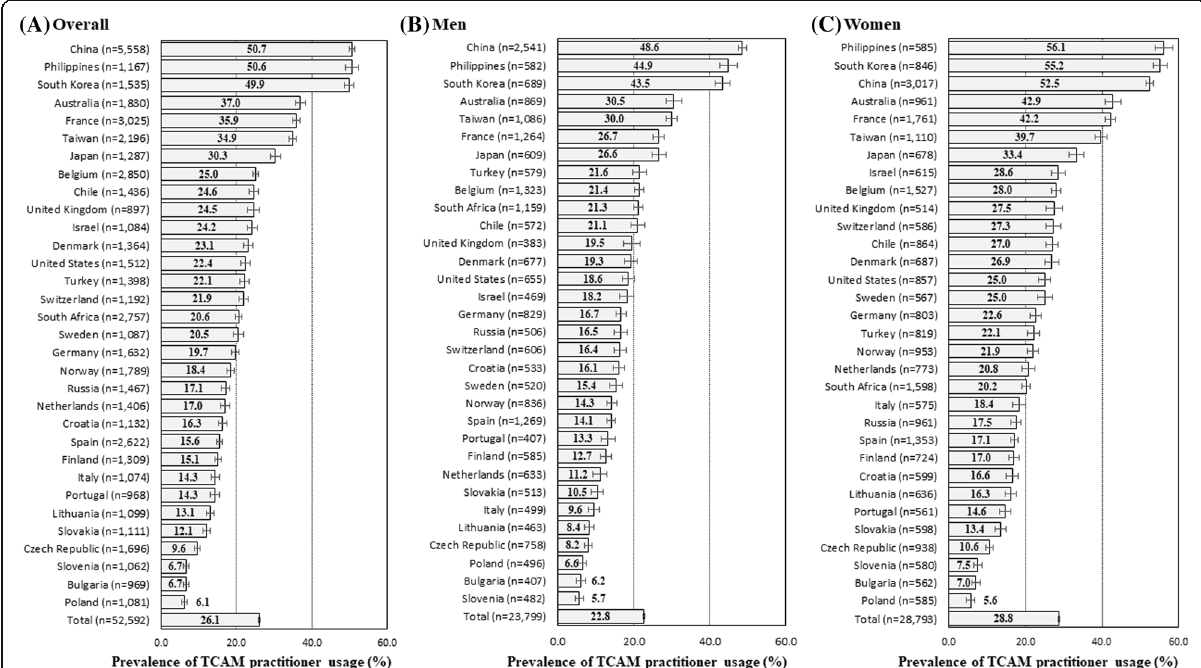
Fig. 2 The prevalence of TCAM practitioner usage among 32 countries. Prevalence of TCAM practitioner usage was stratified by country for ( a ) the Entire Sample, ( b ) Men, and ( c ) Women. Values in parentheses represent the sample size of each